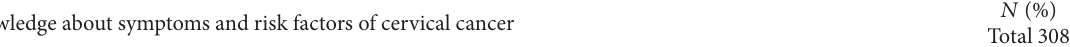
Table 3: Survey results I.